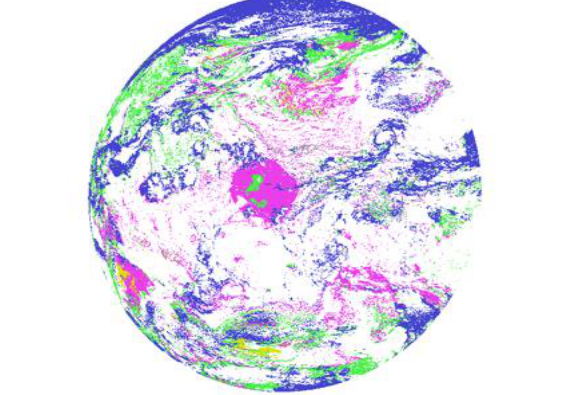
Figure 3. Full-disc FY-4A DSD product acquired from March